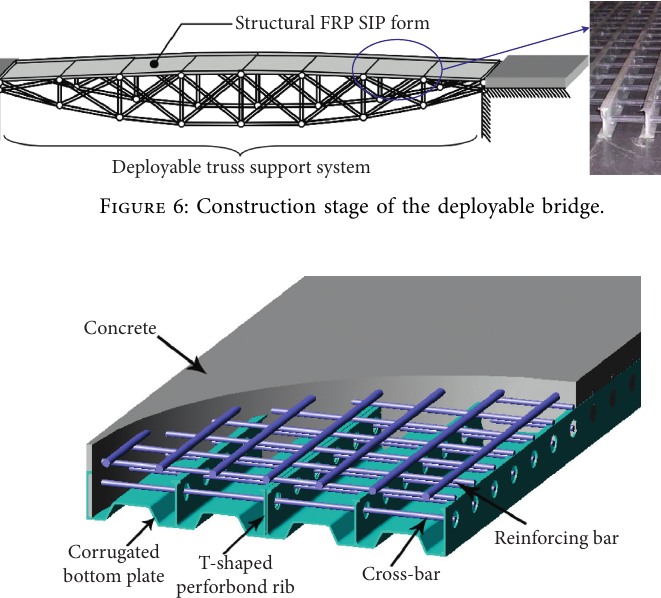
Figure 7: Hybrid deck system proposed by